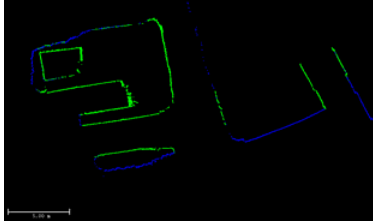
Figure 11. Horizontal section of the southern part of the theatre coloured by cloud: green for the image based point cloud and blue for the TLS point cloud.